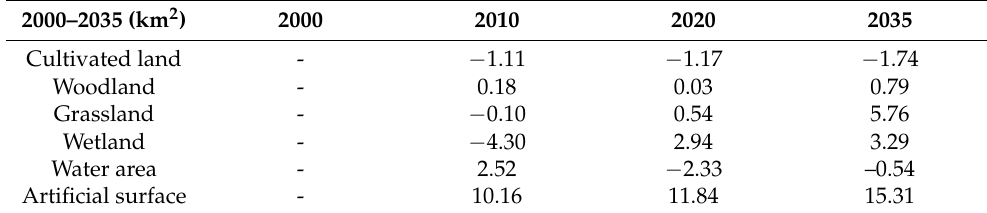
Table 7. Annual land use dynamics from 2000 to 2035.